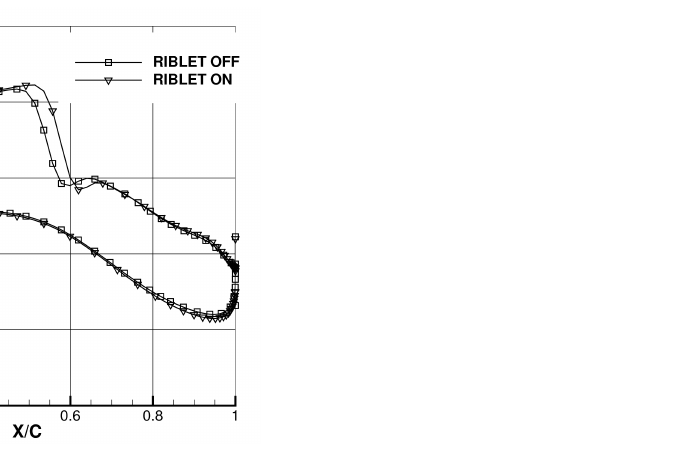
Figure 8. NASA CRM wing body configuration: M ∞ = 0.85, Re ∞ = 5 × 10 6 , α = 2.25 ◦ , η = 0.5024. Effect of riblets on shock wave [16].